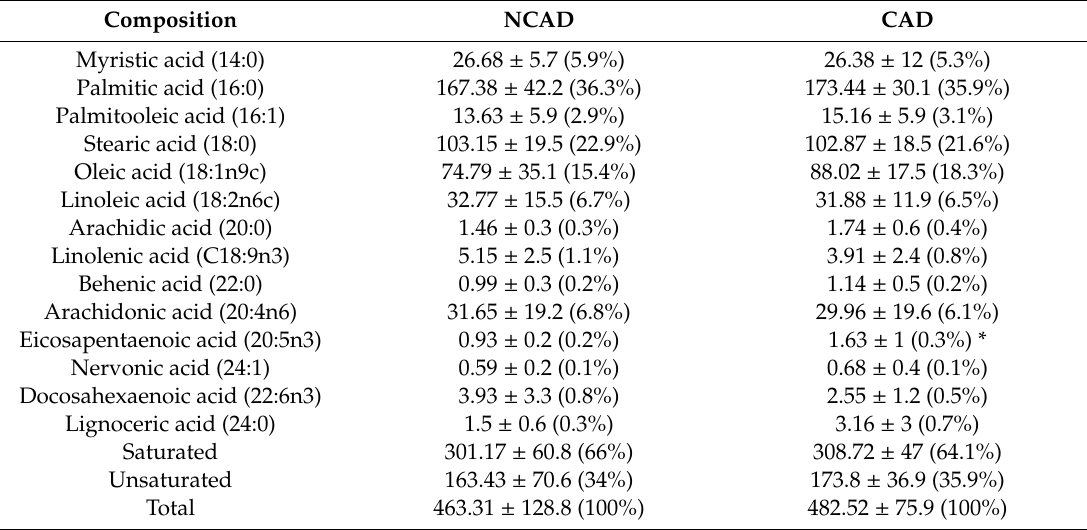
Table 4. FFA—Fatty acid composition (nmol / g of wet